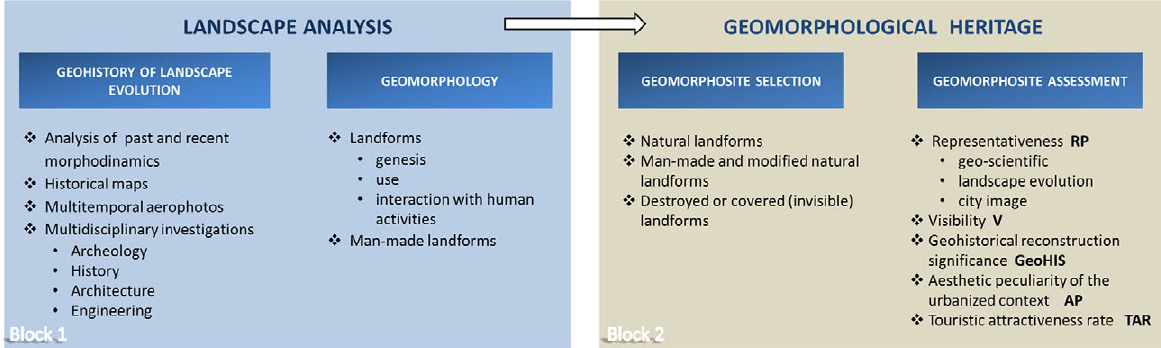
Fig. 1 Methodological approach for urban geomorphology and urban geomorphoheritage